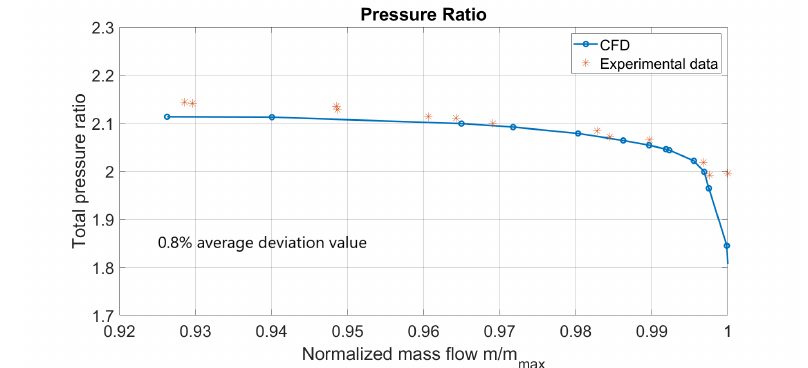
Figure 8. Pressure Ratio comparison between numerical and experimental data.